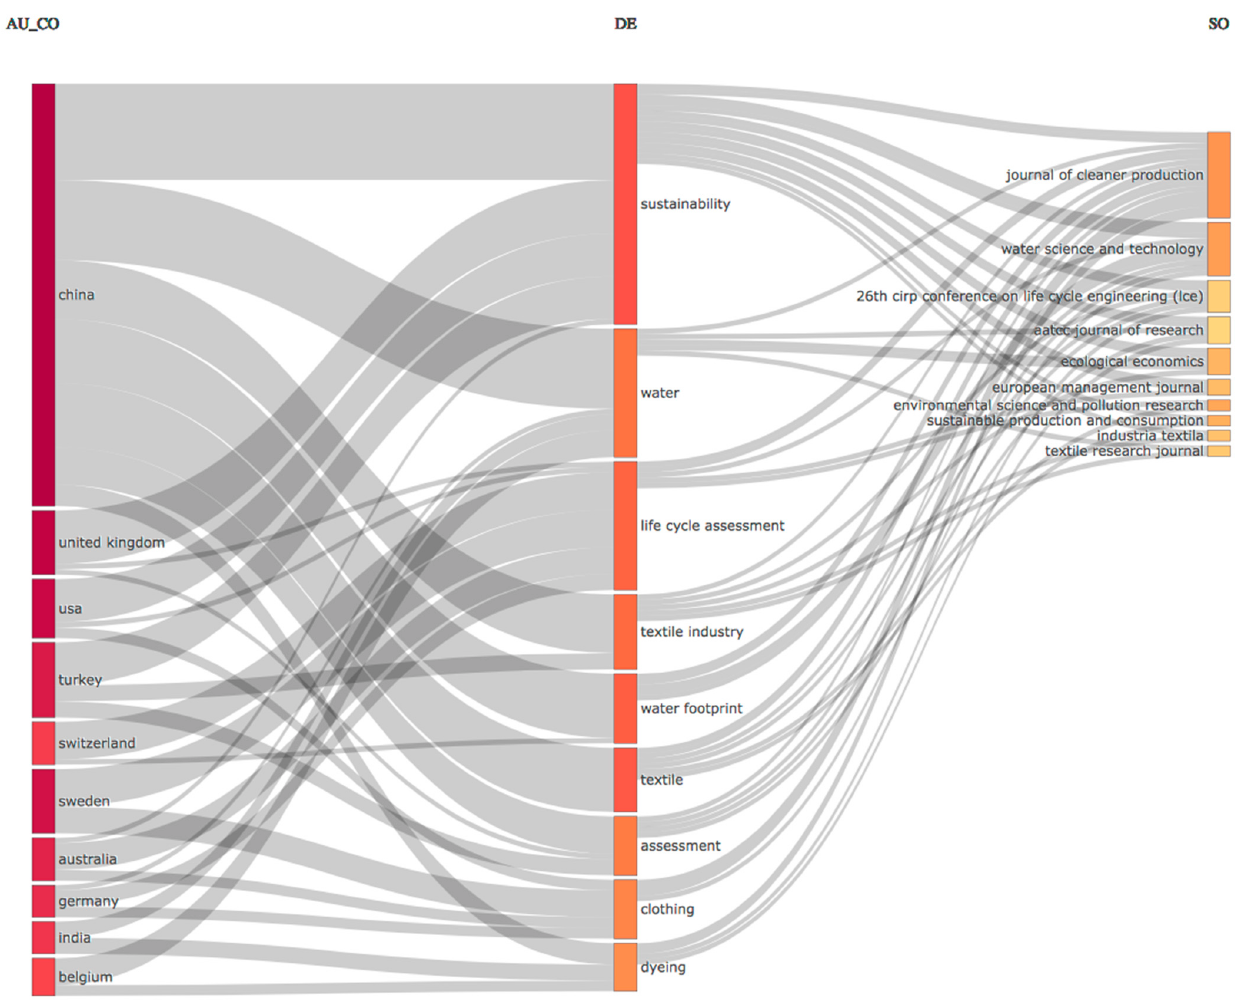
Figure 3. A Sankey diagram (3-field plot) visualisation of the top 10 countries leading research in the field by authors, the main research topics (keywords), and the journals that predominantly publish the articles. Thicker rectangles indicate greater frequency. The connecting nodes, inflows, and outflows indicate more connections with more and thicker nodes.